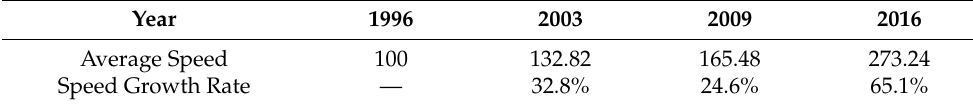
Table 5. Changes of average speed and speed growth rate over the